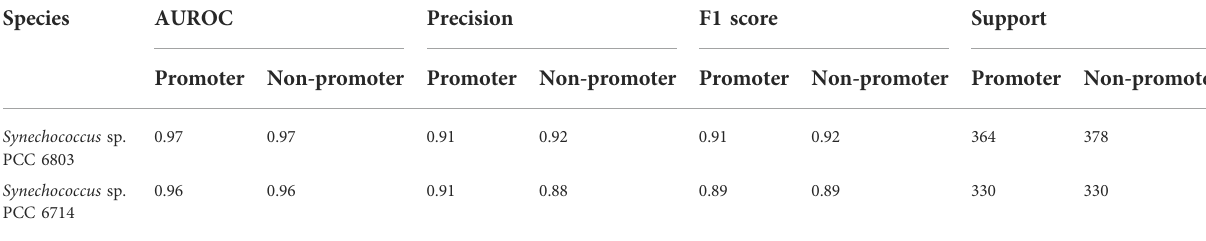
TABLE 5 Cross validation the performance of CyaPromBERT trained on Synechocystis sp. PCC 6803 for a closely related species Synechocystis sp. PCC 6714. Species AUROC Precision F1